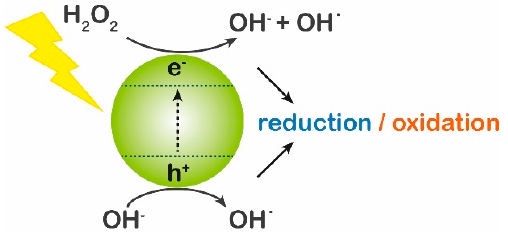
Figure 3. Sketch of a photocatalytic nanoparticle under illumination.